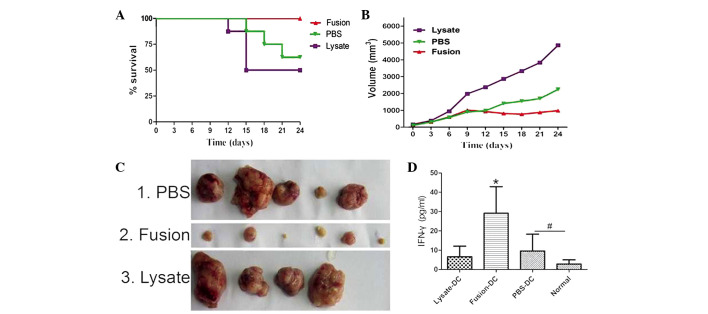
Immunization of C3H/HeJ mice with DC/SCC7 fusion vaccine elicits host resistance against tumor challenge. Mice were challenged by s.c. injection of 2×106 SCC7 tumor cells. At days 7 and 14 following tumor implantation, tumor-bearing mice were vaccinated subcutaneously (s.c.) and intranodally (i.n.) with 2×106 DC/SCC7 hybrids and DCs pulsed with lysate, respectively. (A) Survival time and (B) tumor growth in each group of mice were recorded. (C) Tumor size was determined by measuring the largest perpendicular diameter in mm2 with calipers and recorded every 3 days. (D) IFN-γ cytokine in the serum was determined by ELISA. *P<0.05 and #P>0.05. DC, dendritic cell; ELISA, enzyme-linked immunosorbent assay.